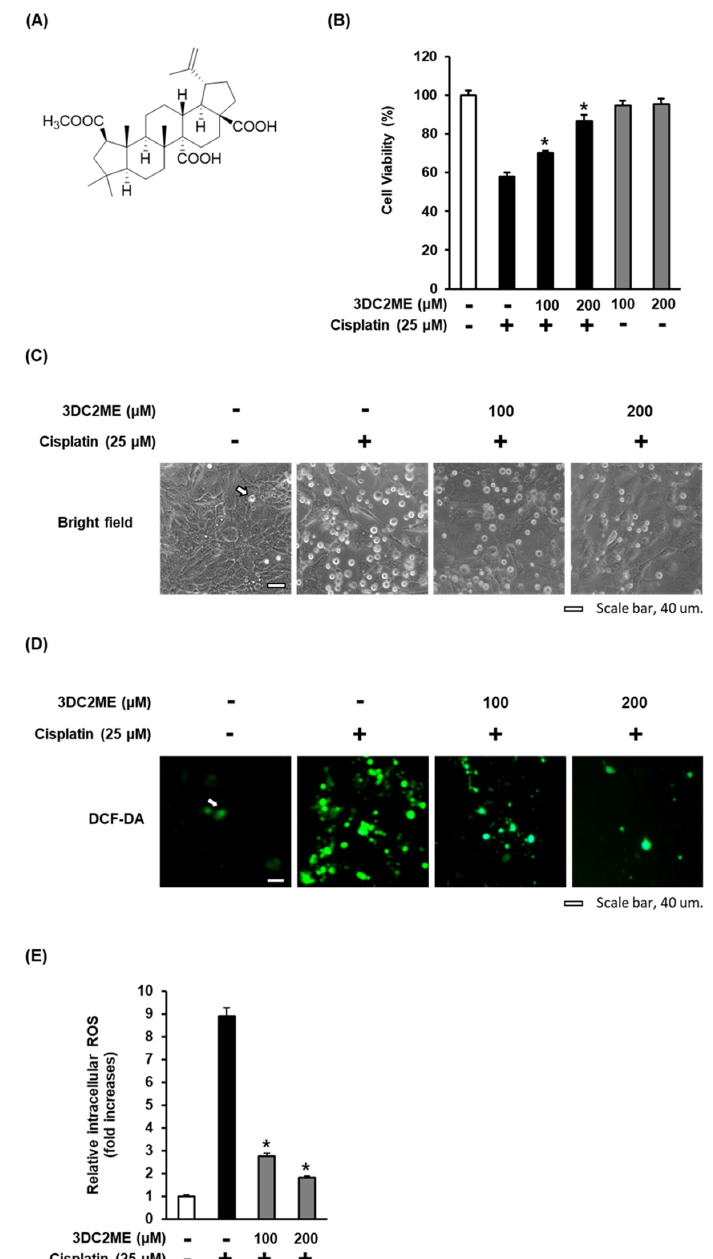
Figure 2. Effect of 3DC2ME on cisplatin-induced oxidative stress in LLC-PK1 cells. ( A ) Chemical structure of 3DC2ME. ( B ) Cell viability as determined using the Ez-Cytox assay after treatment with 25 μ M cisplatin in the presence or absence of 100 or 200 μ M 3DC2ME for 24 h. ( C ) Representative images obtained using an IX50 fluorescent microscope. The white arrows indicate dead cells (scale bar = 40 μ m). ( D ) LLC-PK1 cells exposed to 25 μ M cisplatin in the presence or absence of 100 or 200 μ M 3DC2ME for 24 h and stained with H2DCFDA. Representative fluorescent images were obtained using an IX50 fluorescent microscope. The white arrows indicate intracellular ROS (scale bar = 40 μ m). ( E ) Fluorescent intensity of DCF determined using a fluorescent microplate reader. The fold-increases in intracellular reactive oxygen species (ROS) levels are represented as a bar graph. Control cells were treated with the vehicle only (mean ± SD, * p < 0.05 cisplatin-treated LLC-PK1 cells).